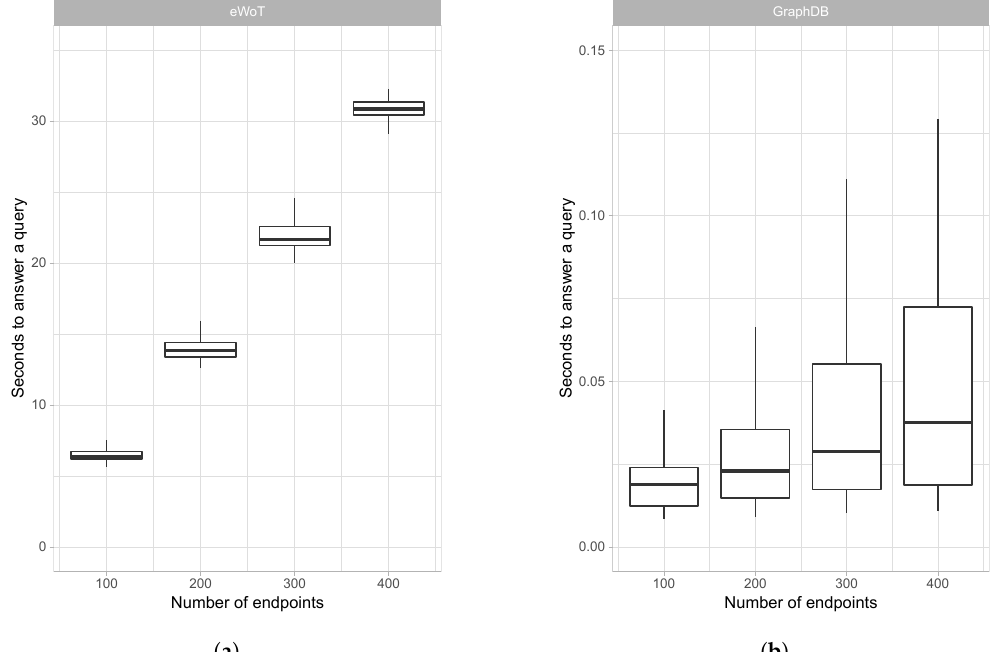
Figure 6. Comparison of eWoT and centralised approach based on GraphDB: ( a ) eWoT query-answering time and ( b ) GraphDB query answering